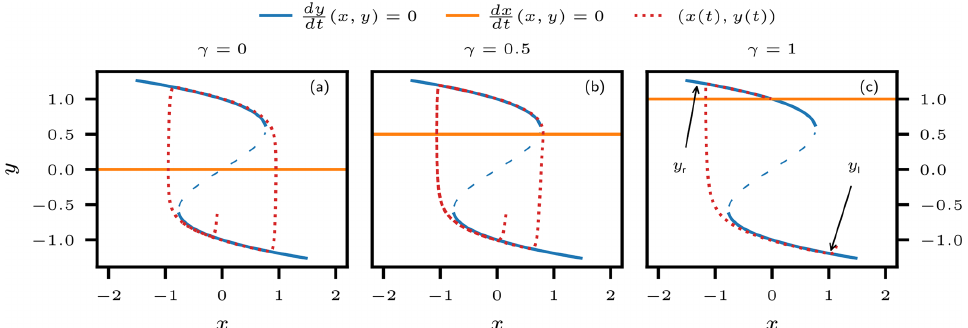
Figure 9. Nullclines of the autonomous FHN model governed by Eq. (22) with large timescale separation, for α = 2, τ x = 100, and τ y = 10; the nullclines of the fast y component are in blue, and those of the slow x component are in orange. (a–c) One illustrative trajectory (red dotted) for γ = 0, 0.5, and 1.0, respectively. The upper branch and the lower branch of the y nullcline (solid blue) correspond to the roots y r and y l , respectively, as defined in the text. For fixed values of x , they constitute stable fixed points for Eq. (22b). The middle branch (dashed blue) corresponds to the unstable fixed point for Eq. (22b) for a given x . The trajectories for panels (a) and (b) follow a limit cycle, as the √ x nullcline does not intersect with either of the stable branches of the y nullcline, given that | γ | < 1 / 3, while the trajectory in panel (c) approaches a single stable fixed point for the coupled system formed by the intersection of the x nullcline with the y l branch of the y